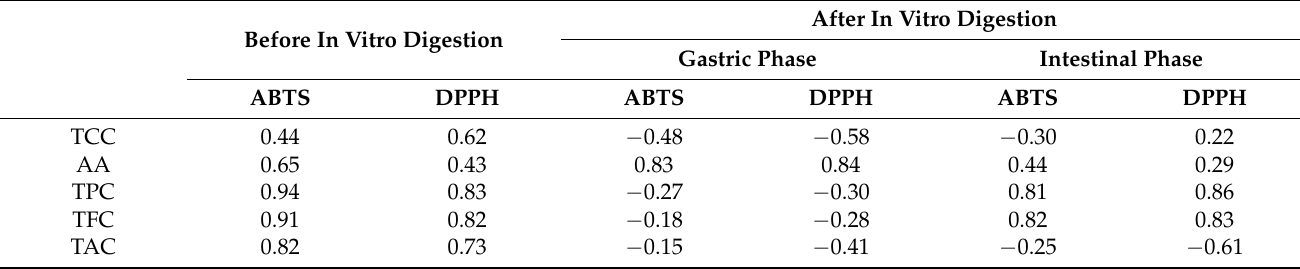
Table 9. Pearson correlation coefficients among the antioxidant capacity and antioxidant compounds of 12 ecotypes of S. purpurea L. before and after in vitro